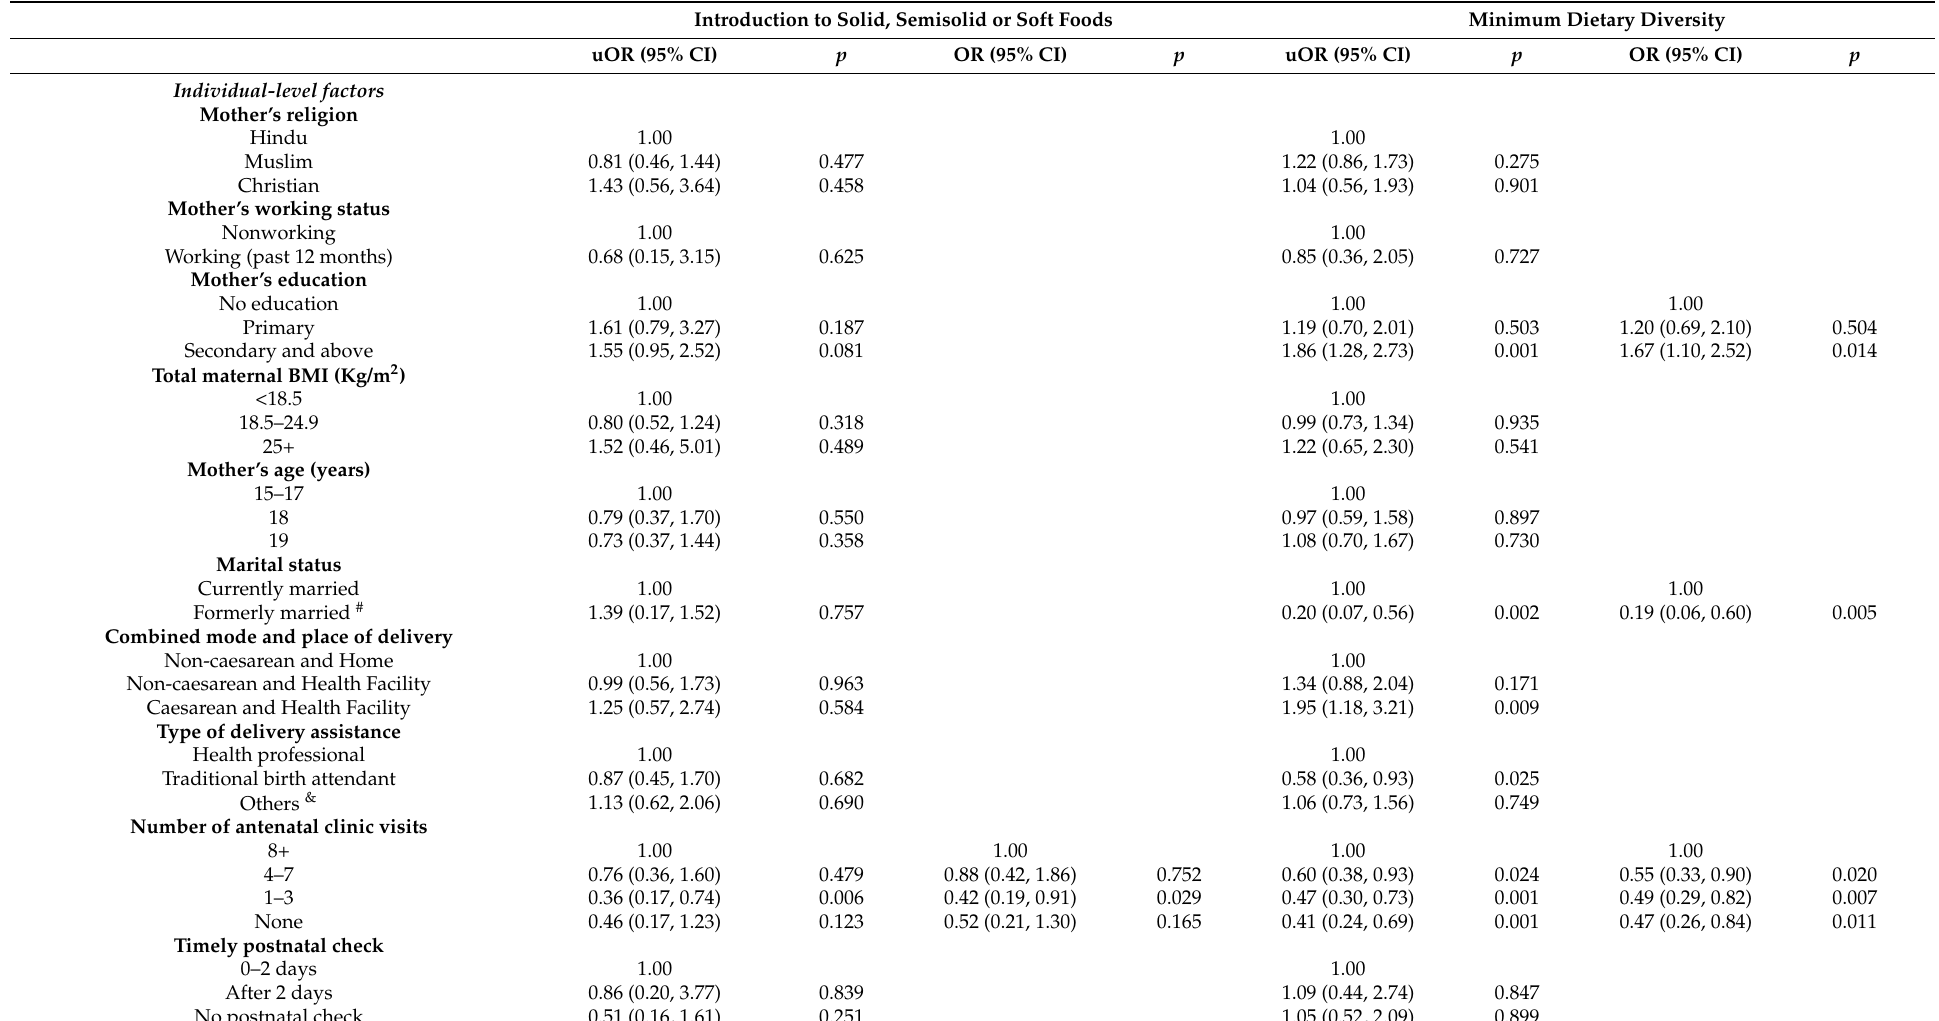
Table 5. Factors associated with introduction to solid, semisolid, or soft foods and minimum dietary diversity in adolescent Indian mothers, 2015–2016 NFHS. Introduction to Solid, Semisolid or Soft Foods Minimum Dietary